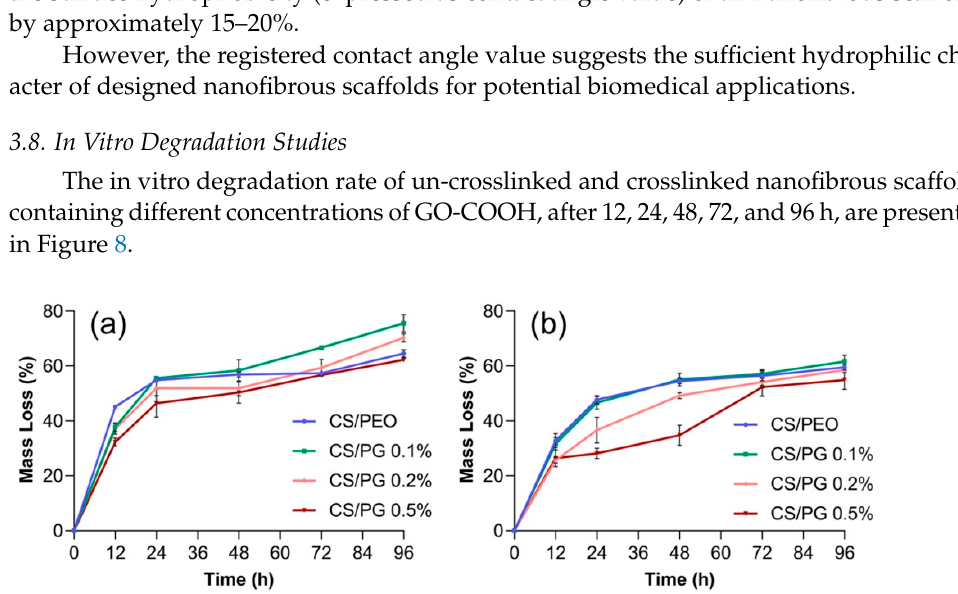
Figure 8. In vitro degradation rate of ( a ) un-crosslinked and ( b ) crosslinked nanofibrous scaffolds in PBS solution after 12, 24, 48, 72, and 96